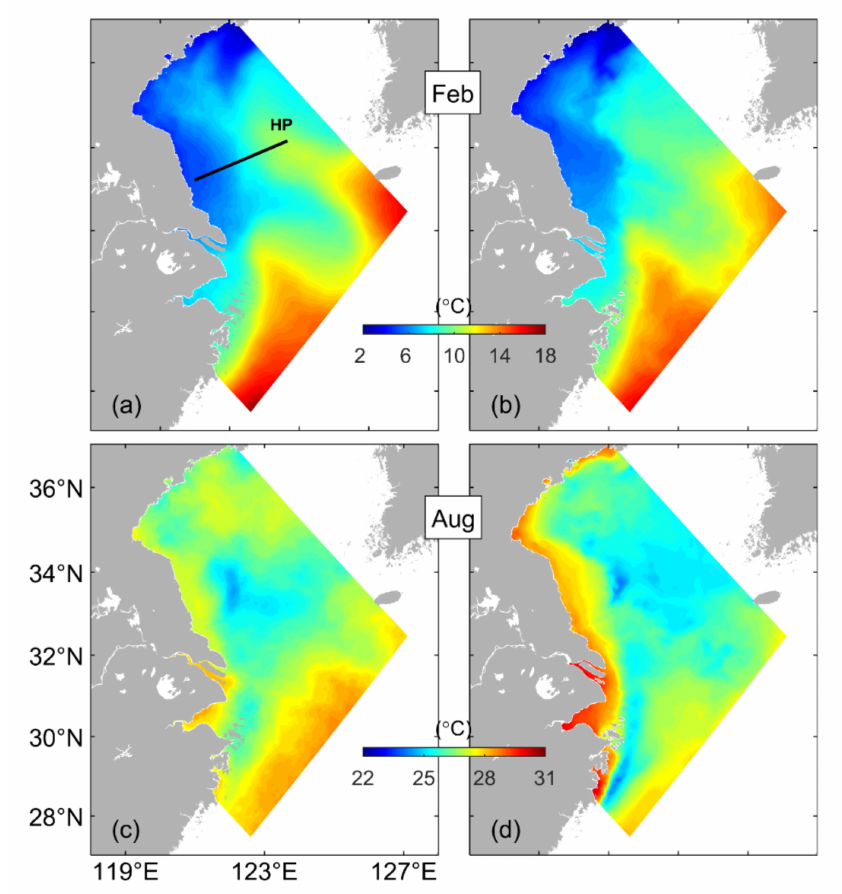
Figure 5. Monthly mean SST in February ( a , b ) and August ( c , d ) 2015 computed from ( a , c ) MURSST and ( b , d ) the inner model results in the case of CR. The black line in ( a ) represents transect HP used in examining model